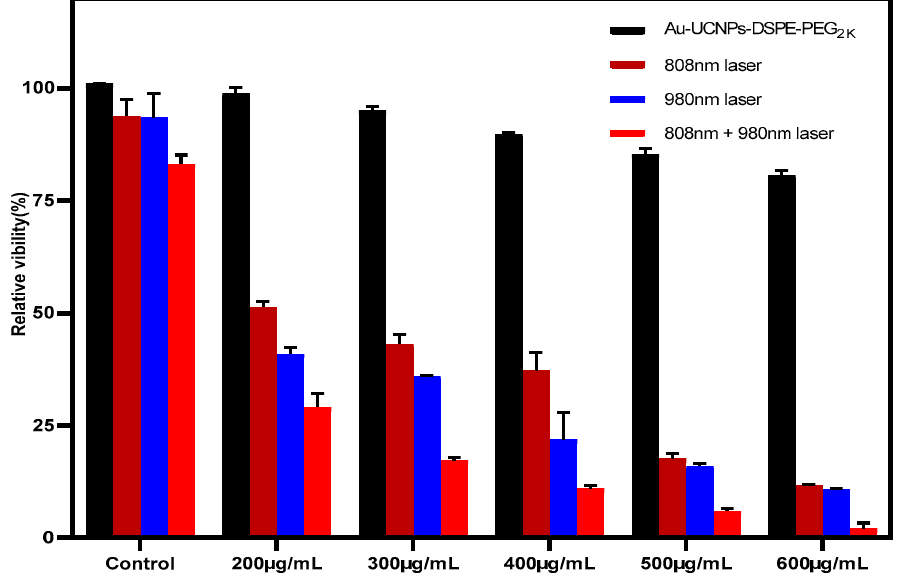
Figure 6. Cytotoxicity (Calculated from the absorbance measured by the microplate reader at OD = 450 nm) of different concentrations of Au-UCNPs-DSPE-PEG2K and different conditions (both the 980 nm wavelength and the 808 nm wavelength are emitted by a laser with a power of 500 mW and an irradiation radius of 12 cm).